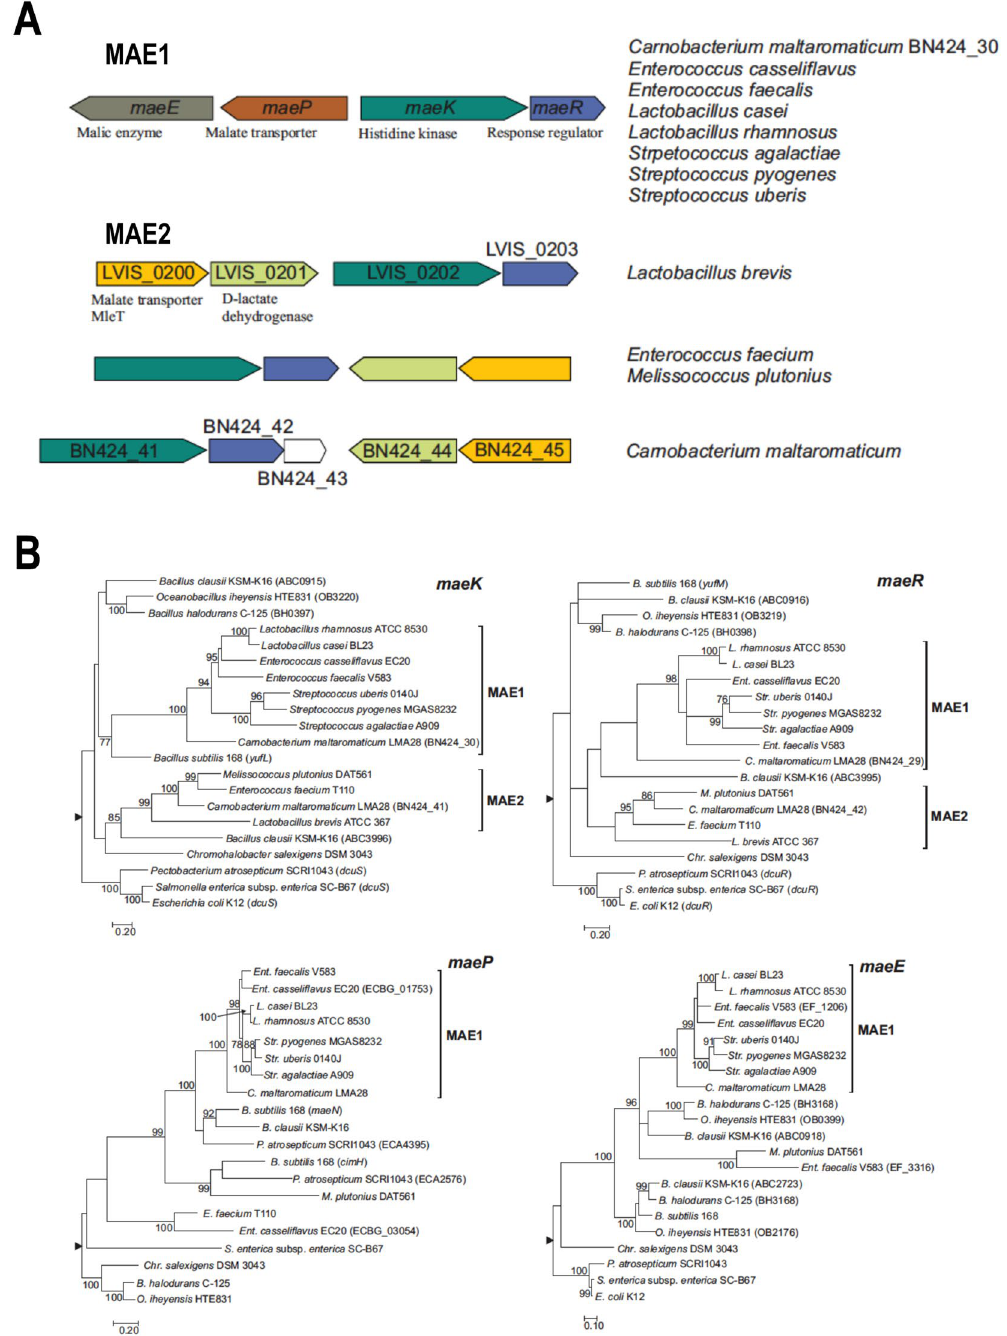
Figure 2. Clusters of mae genes and phylogenetic analysis. ( A ) Arrangements of gene clusters present in the specified species. Colours indicate homologous genes. Arrows indicate the direction of transcription. ( B ) Maximum-likelihood phylogenetic trees of homologous cluster genes. The trees are arbitrarily rooted using the mid-point rooting method implemented in Mega software 64 (black triangle; see Methods). Only bootstrap support values higher than 75% are shown. Genes belonging to Mae1 and Mae2 groups are indicated. Gene names or gene-tags are indicated in brackets when paralogous genes were included in the